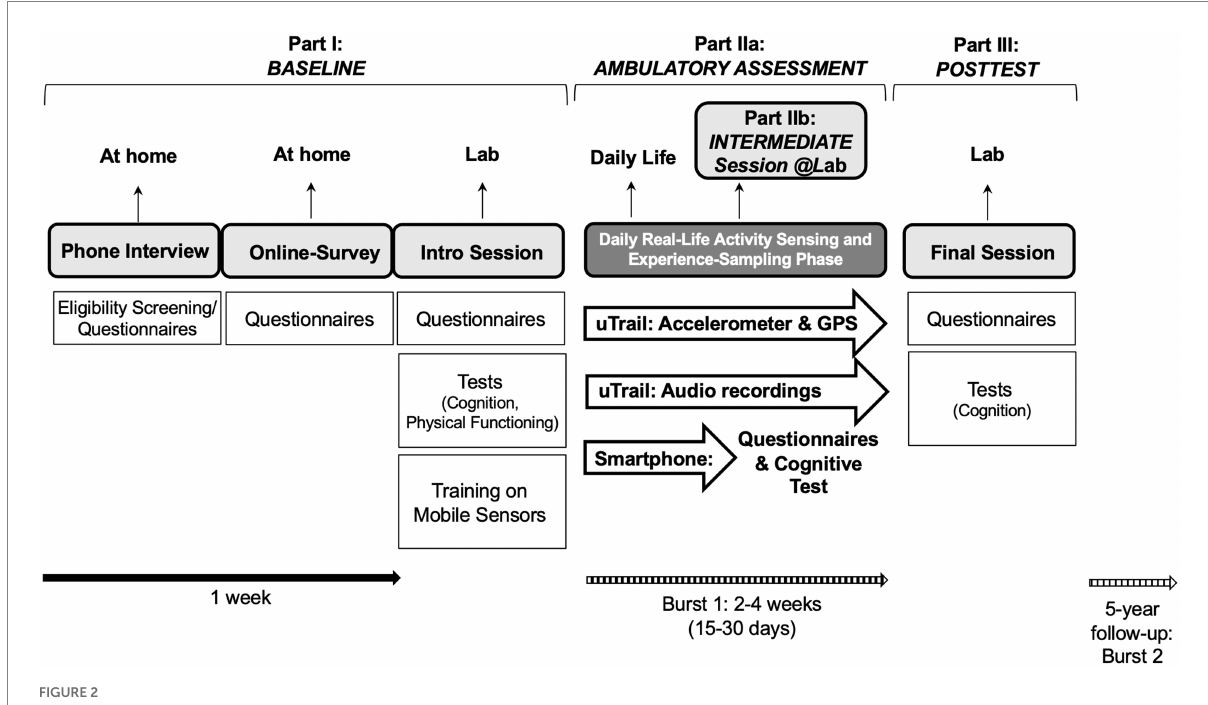
FIGURE 2 Design of the MOASIS project (first